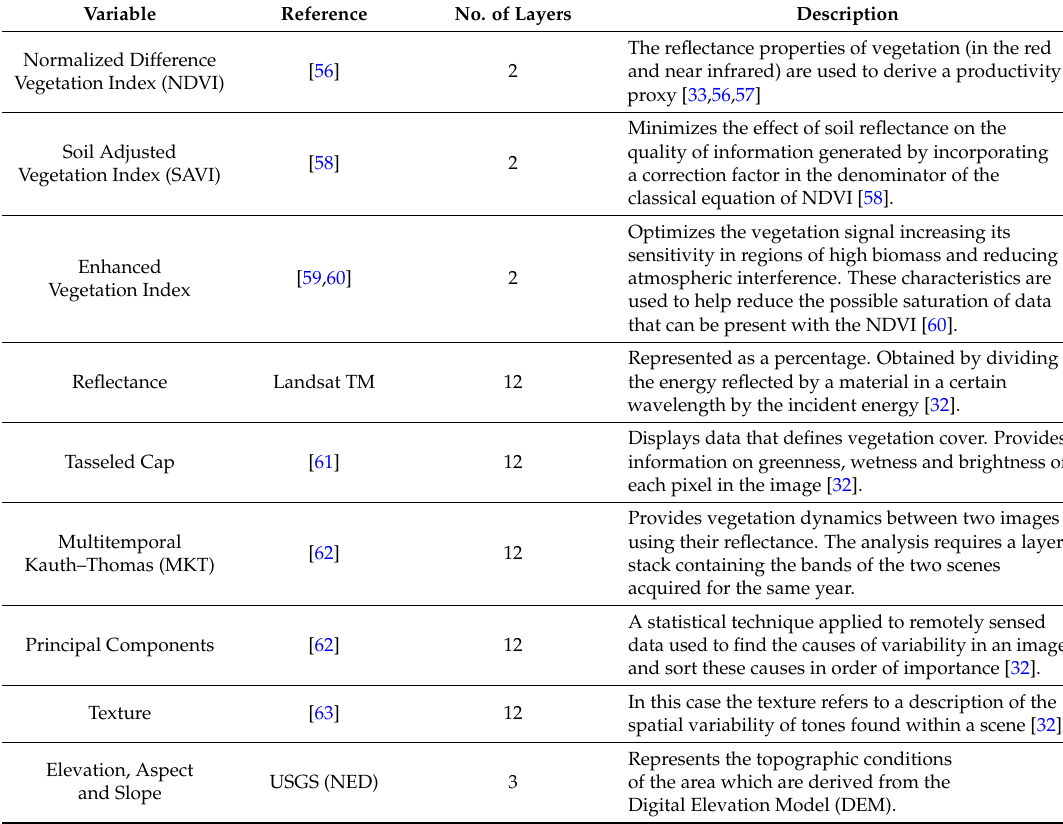
Table 3. Variables used in the land cover classification derived from Landsat spectral reflectance data and a Digital Elevation Model